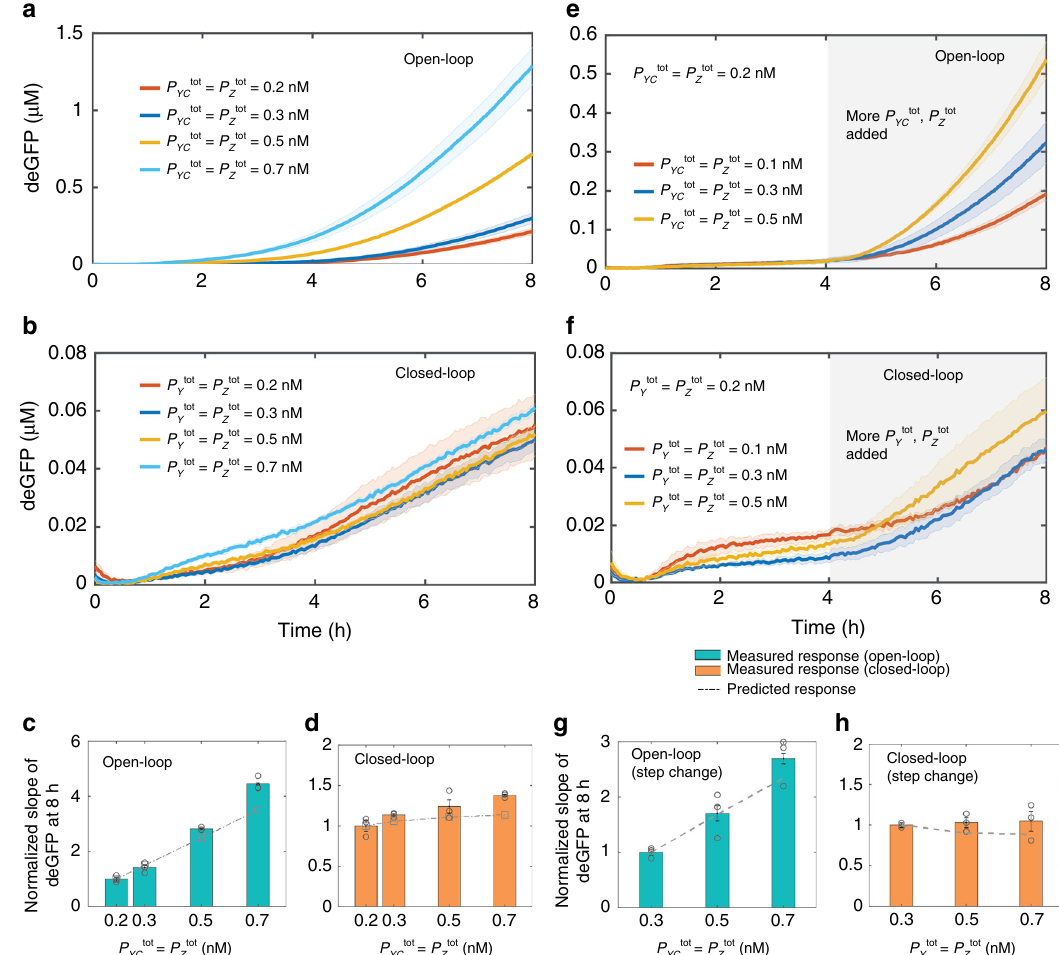
Fig. 5 Closed-loop operation enables the controller to achieve robustness to the local disturbance on the system. a, b Measured deGFP response of the controller in the presence of disturbances in the concentration of P YC tot (or P tot Y ) and P tot Z (0.2 – 0.7 nM) for the a open-loop and b closed-loop cases while initial P X was 0.2 nM. The error bars are shown in the shaded region and were determined using the standard error of the mean of three or more repeats. c , d Summary of the deGFP slopes of the controller at 8 h for the c open-loop and d closed-loop operations. Error bars are from the SEM of at least three repeats. To disable the feedback in the open-loop case P tot Y was replaced by P tot YC , which expresses a protein that cannot sequester with X . e, f Measured response of the controller when the disturbance in P tot Y and P tot Z was added in a step manner for the e open-loop and f closed-loop cases. Additional P tot Y and P tot – 0.5 nM) after 4 h of the reaction in the presence of initial 0.2 nM of P X , P tot P tot Z were added (0.1 Y and Z each. g , h Summary of the normalized deGFP slopes of the controller at 8 h for the g open-loop and h closed-loop operations. Normalization was done with respect to the fi rst slope value for each variation in P tot Y and P tot Z . The predicted response for each case was determined using the ODE model shown in Fig. 3b with parameters shown in Table 1. Before calculating deGFP slopes, measured deGFP responses were smoothed-out using the rloess smoothing method in MATLAB. Source data are provided as a Source Data fi